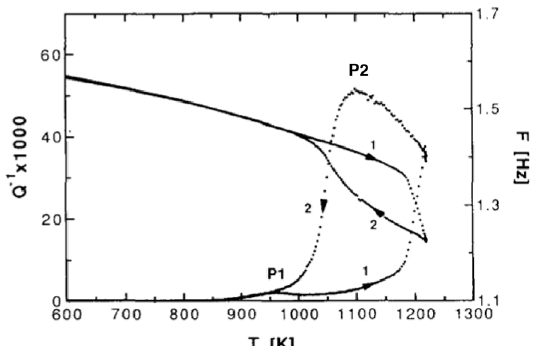
Figure 4. Hysteretic behaviour in Ni-20at.%Cr. The peak P2 only appears if sample is heated above 1200 K